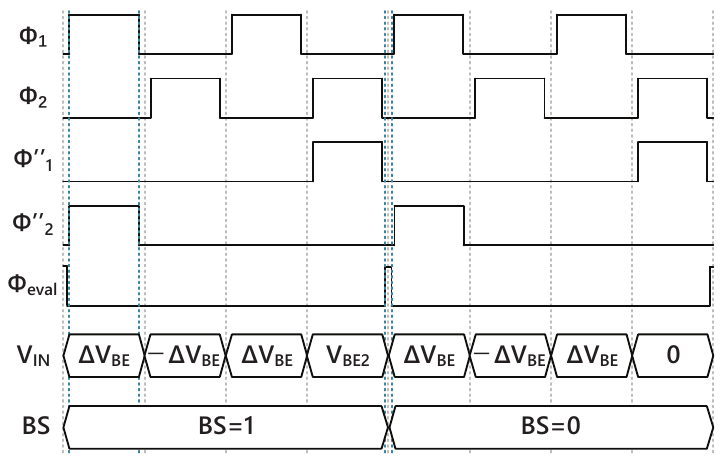
Figure 8. Timing diagram of the incremental ∆ - Σ